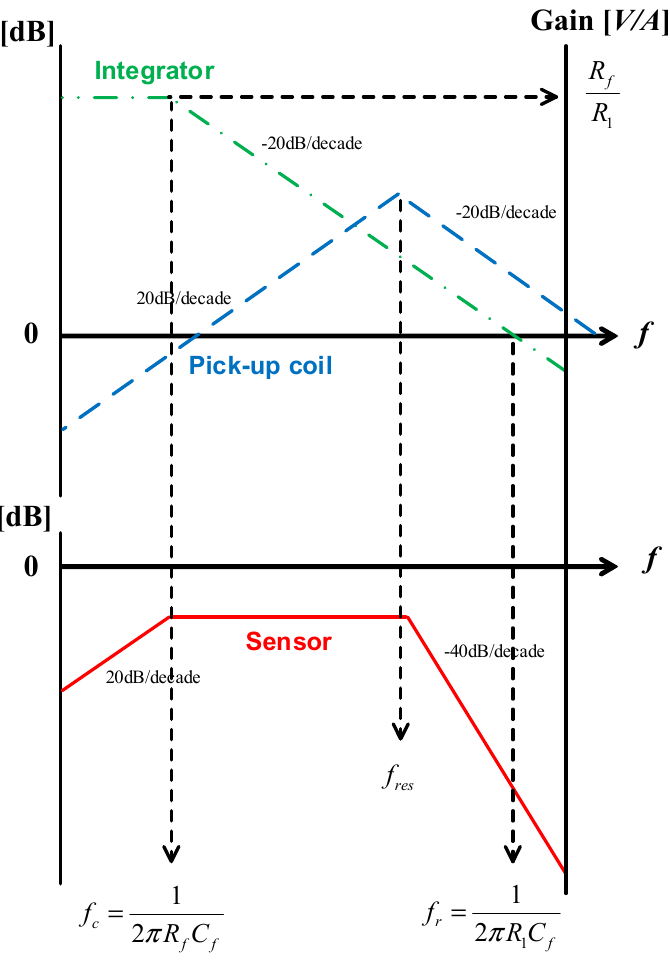
Figure 5. Frequency characteristics of a sensor with an active integrator.